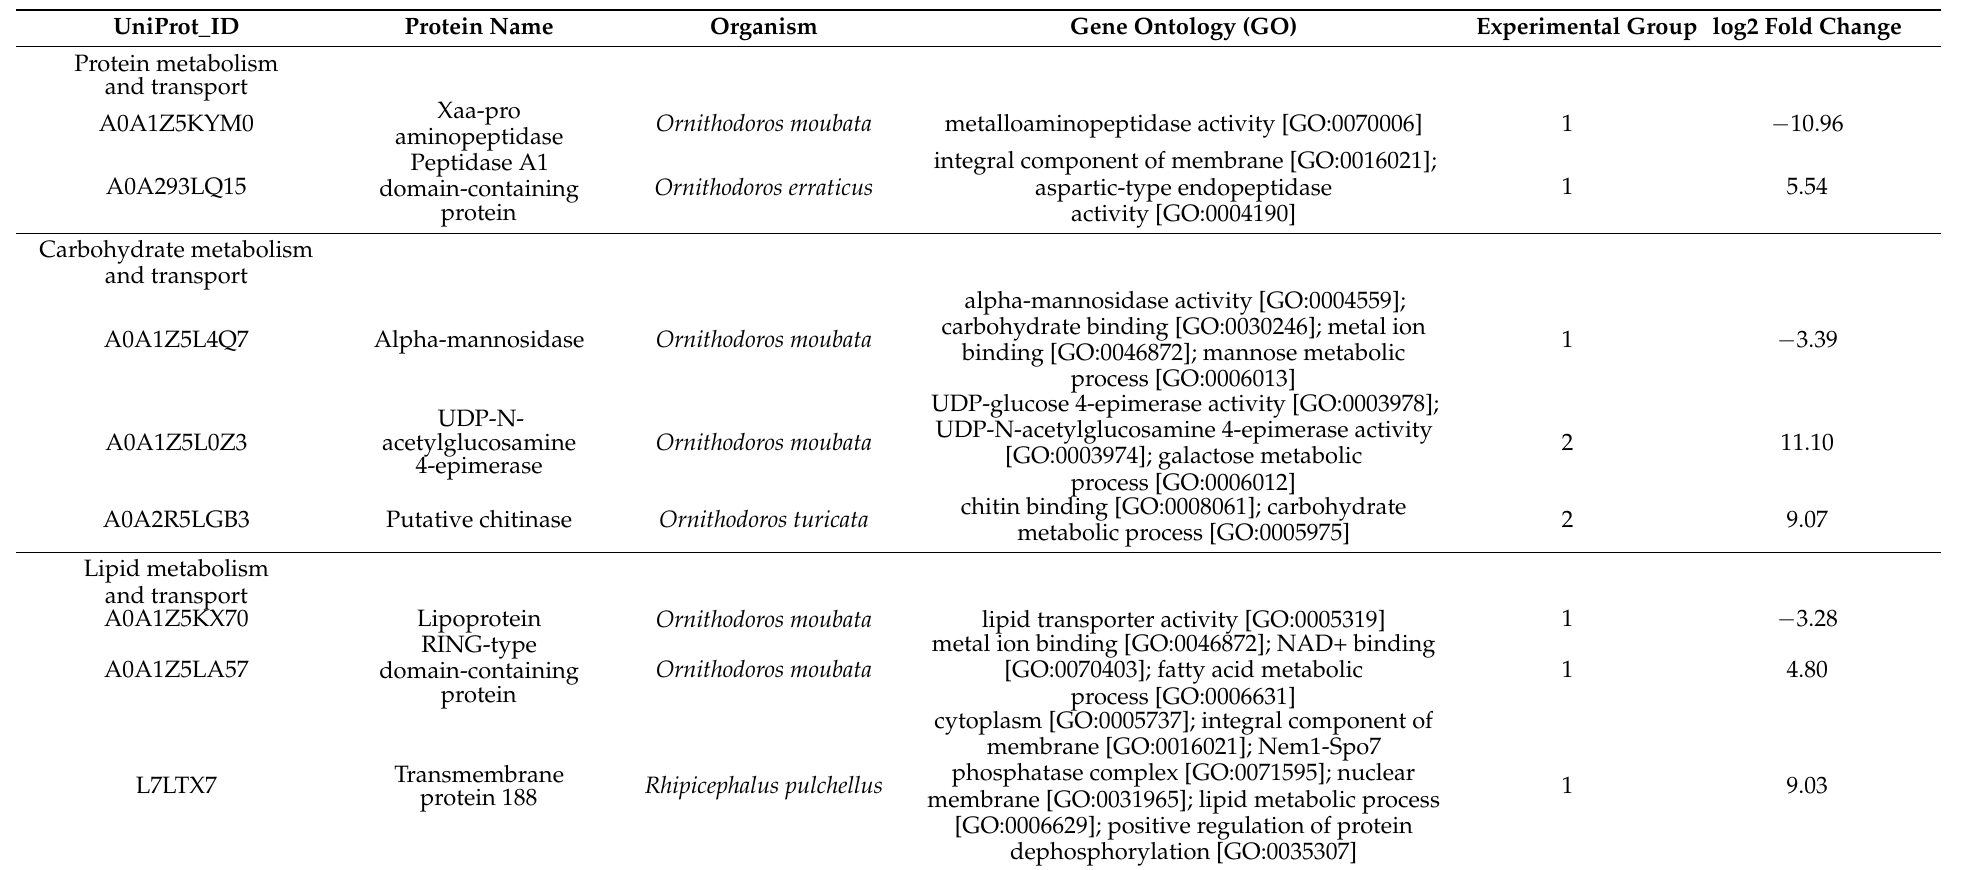
Table 2. Selected genes predicted to be involved in protein metabolism, carbohydrate metabolism and transport, lipid metabolism and transport and response to oxidative stress. It is shown the Fold Change Value. Experimental groups 1 and 2 refer to “engorged vs. unfed—non-infected” and “ Borrelia duttonii -infected vs. non-infected—engorged”,